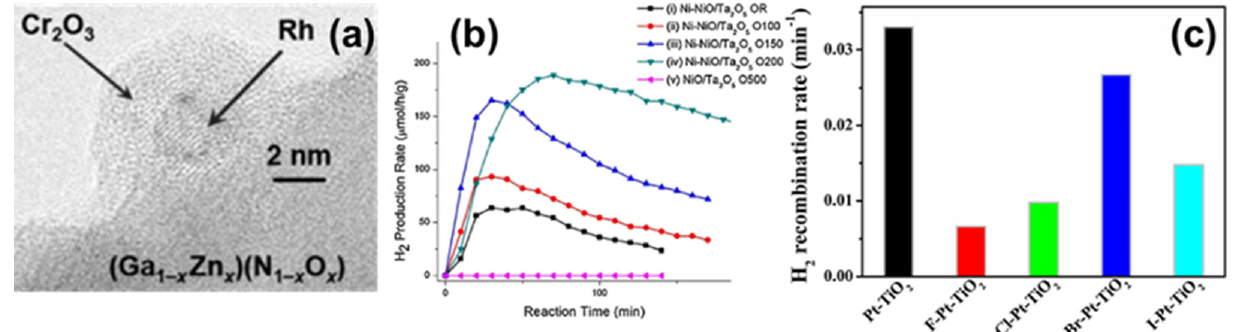
Figure 7. Core–shell structured cocatalyst.